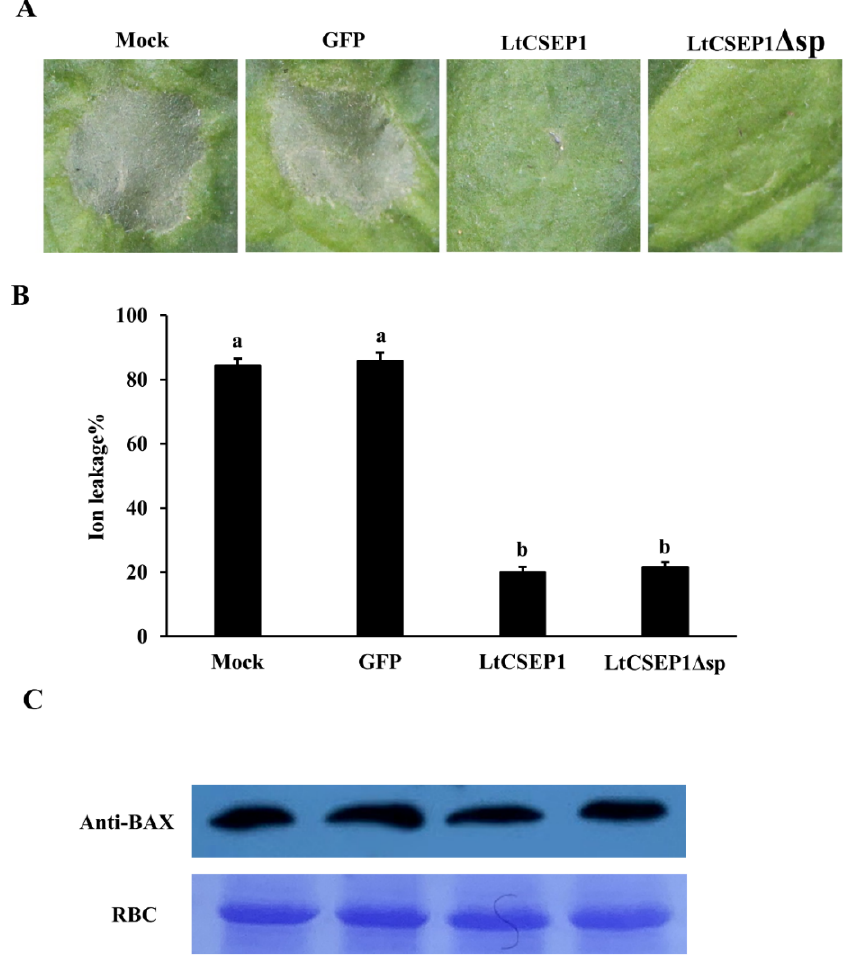
Figure 3. LtCSEP1 suppressed BAX-triggered cell death in Nicotiana benthamiana . ( A ) N. benthamiana leaves were infiltrated with Agrobacterium tumefaciens GV3101 containing pGR107 vector carrying Green fluorescent protein (GFP), LtCSEP1 or LtCSEP1 ∆ sp (LtCSEP1 without the signal peptide sequence), respectively, followed by expression of the BAX 12 h later. Photos were taken 5 days post infiltration. The experiments were repeated three times with similar results. ( B ) Quantification of cell death by measuring ion leakage in the infiltrated N. benthamiana leaves. Ion leakage from leaf discs infiltrated with Agrobacterium cells was measured at 3 days post infiltration of BAX. Different letters represent significant differences ( p < 0.05). ( C ) The presence of BAX proteins was detected by western blotting with anti-BAX antibodies.